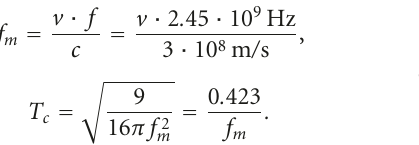
Table 3: Calculated maximum Doppler frequency and coherence time for the approximate walking